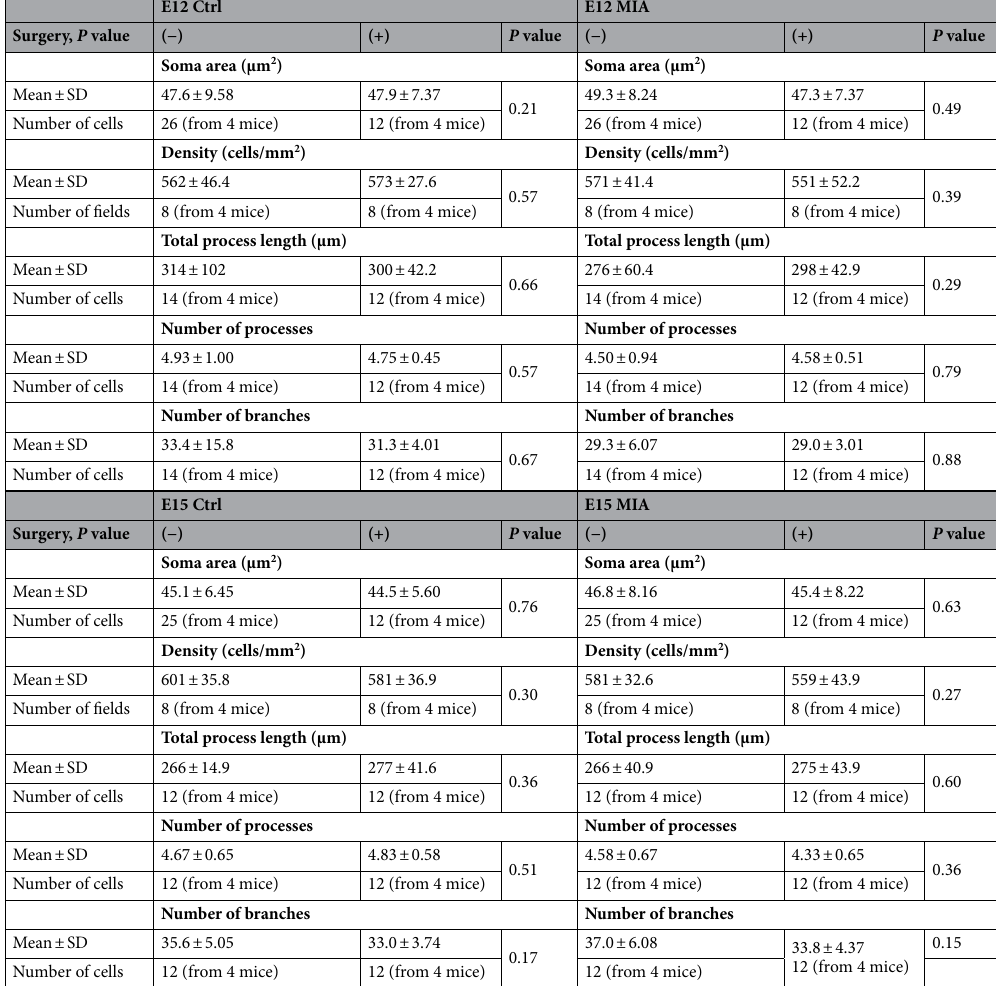
Table 5. Comparison of morphological properties between P10 microglia with and without surgery.